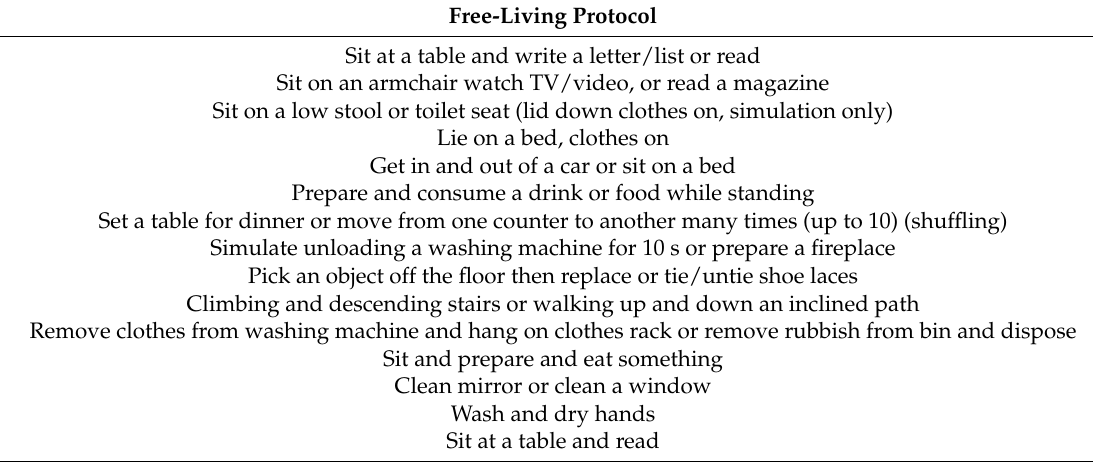
Table 5. The free-living unsupervised task-based protocol.